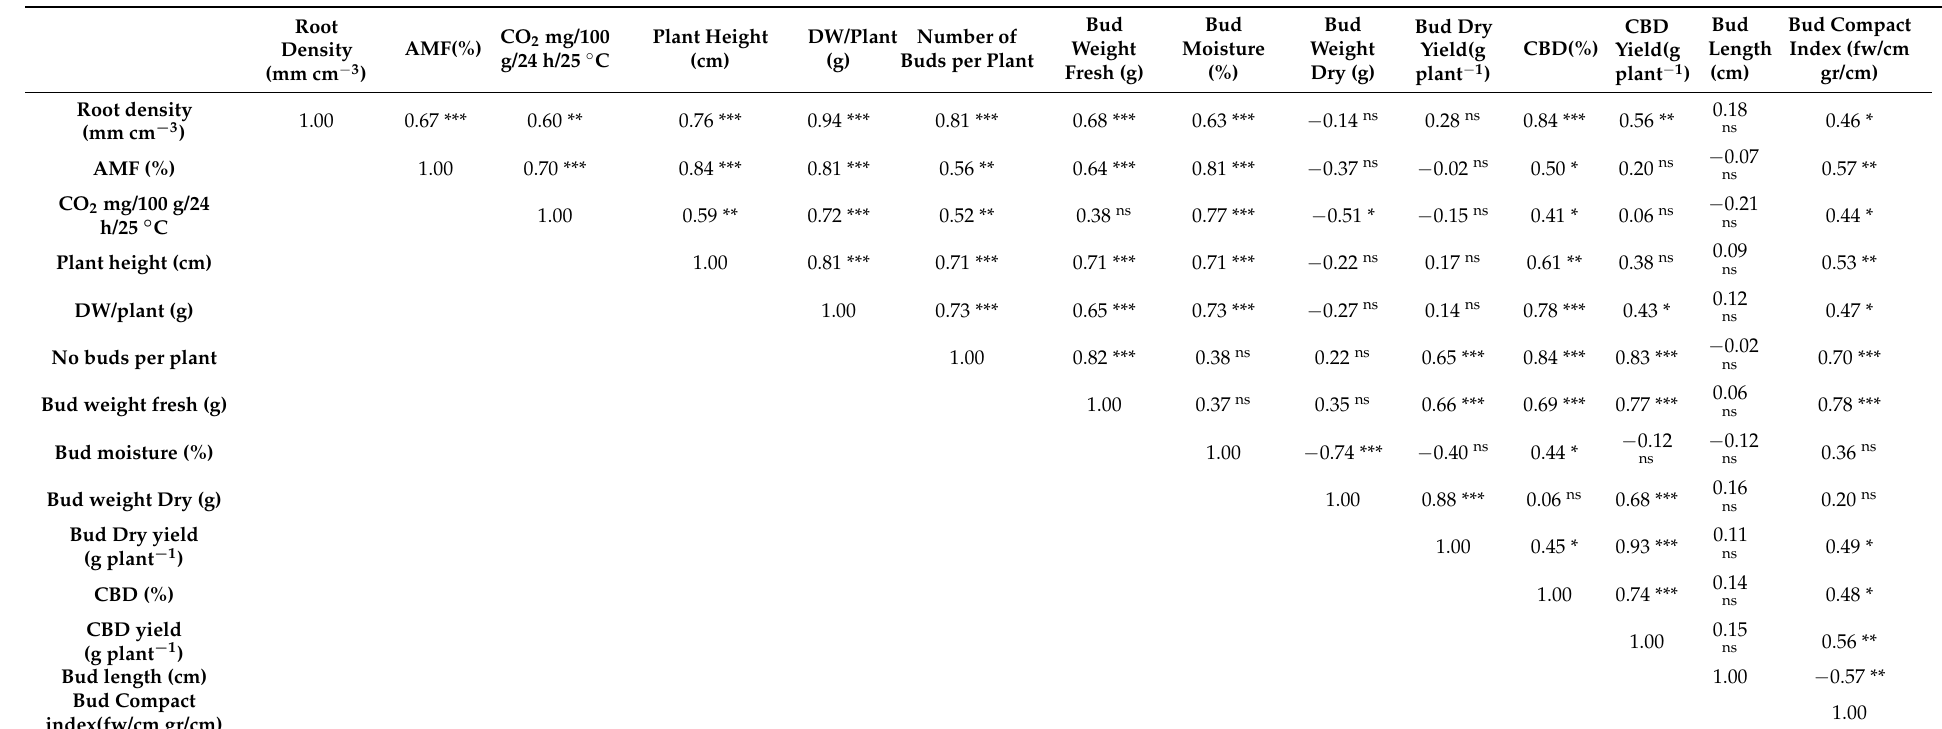
Table 5. Correlation matrix between agronomic, yield characteristics, and CBD content of hemp varieties (Fedora 17 and